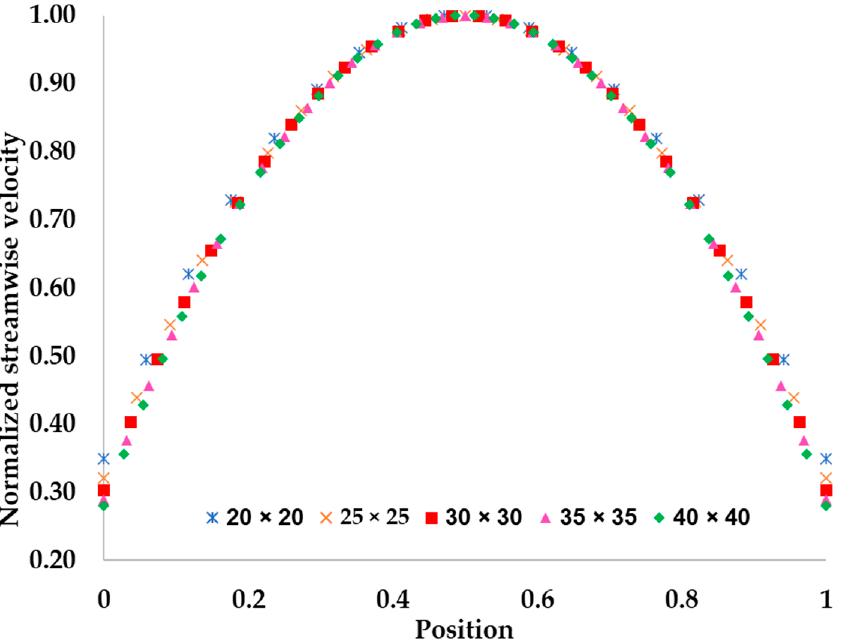
Figure 11. Pressure-drop results from generalized periodic, pressure, and periodic boundary condi- tions in a slit nanopore. Y axis represents pressure difference with respect to the outlet.